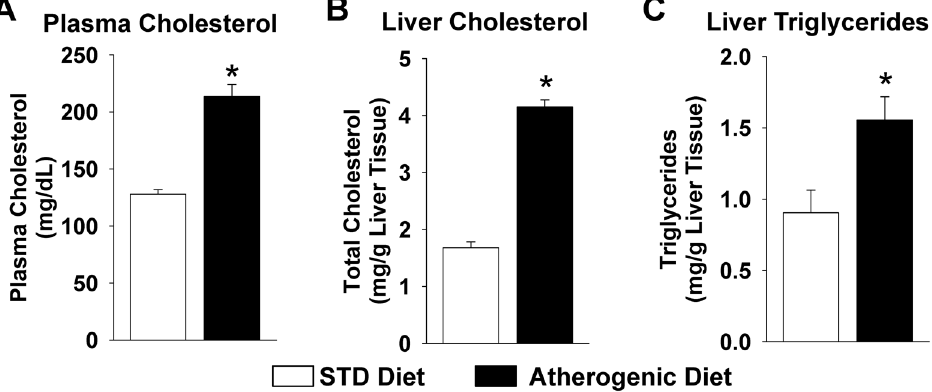
Figure 1. Plasma and hepatic lipid levels increase in response to atherogenic diet administration. (A) Plasma total cholesterol levels, (B) liver total cholesterol levels, and (C) liver triglyceride levels were significantly higher in mice administered the atherogenic diet for 4 weeks compared to mice administered the STD diet (STD diet: n=6–10, atherogenic diet: n=13–22). *P , 0.05 vs. STD diet group.